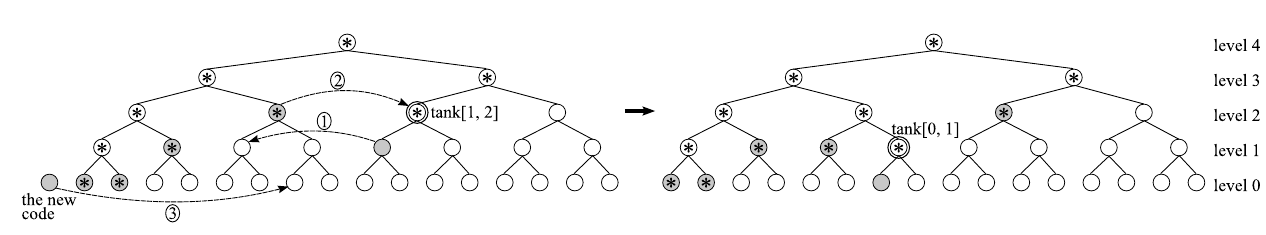
Figure 5. An execution of Case